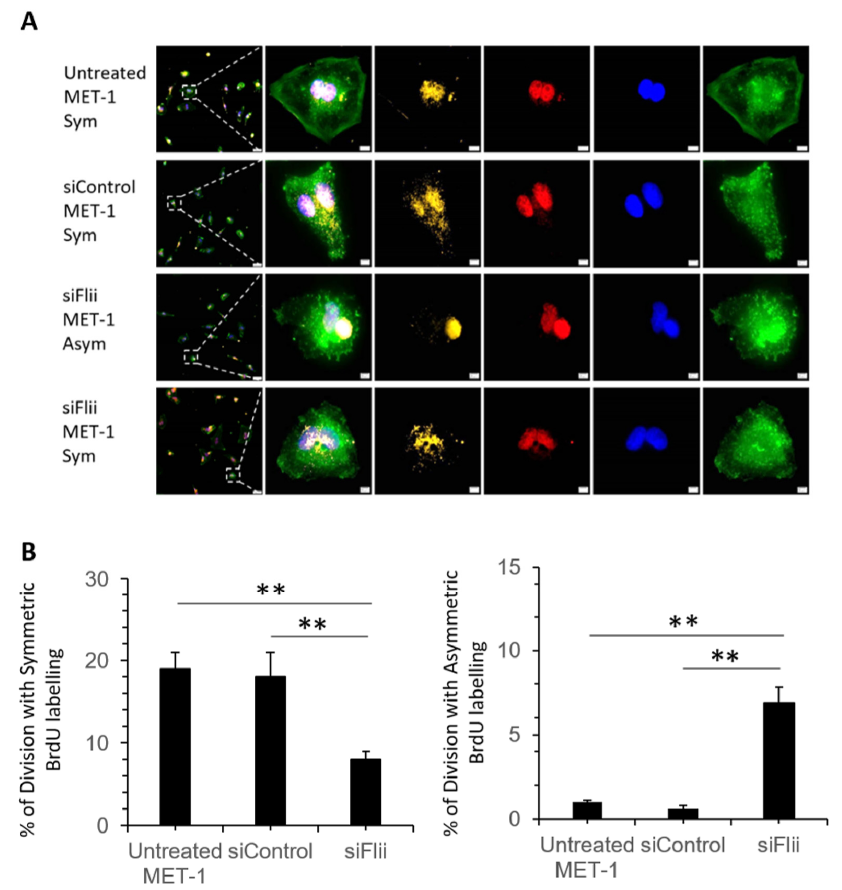
Figure 4. Effect of Flii knockdown on cell division pattern of human cSCC cell line. ( A ) Representa- tive images of MET-1 cells (untreated), siControl-MET-1, siFlii-MET-1 cells undergoing symmetric (Sym) or asymmetric (Asym) division following siRNA knockdown and BrdU-cytD pulse-chase la- beling with a total time of 48 h. Triple immunofluorescent staining of BrdU (yellow) showing DNA synthesis in proliferating cell, pH3 (red) identifying mitotic chromosomes during metaphase of pro- liferation and phalloidin (green) identifying actin filaments and nuclear DAPI (blue) staining. Asymmetrically dividing cells show skewed inheritance of BrdU-labeled DNA at the end of meta- phase and symmetrically dividing cells show equal inheritance of BrdU-labeled DNA at the end of metaphase. Arrest of cytokinesis by cytD is confirmed by phalloidin staining showing disrupted formation of actin filaments in granular shape. Scale bars, 5 μ m. ( B ) Quantification of mitotic cells undergoing symmetric or asymmetric division following BrdU-labeling, illustrating a decreased symmetric division and increased asymmetric division following Flii knockdown. Data represent the mean from three independent experiments with an average of 30 mitotic events per group. Mean ± SEM. n = 30. ** p < 0.005.